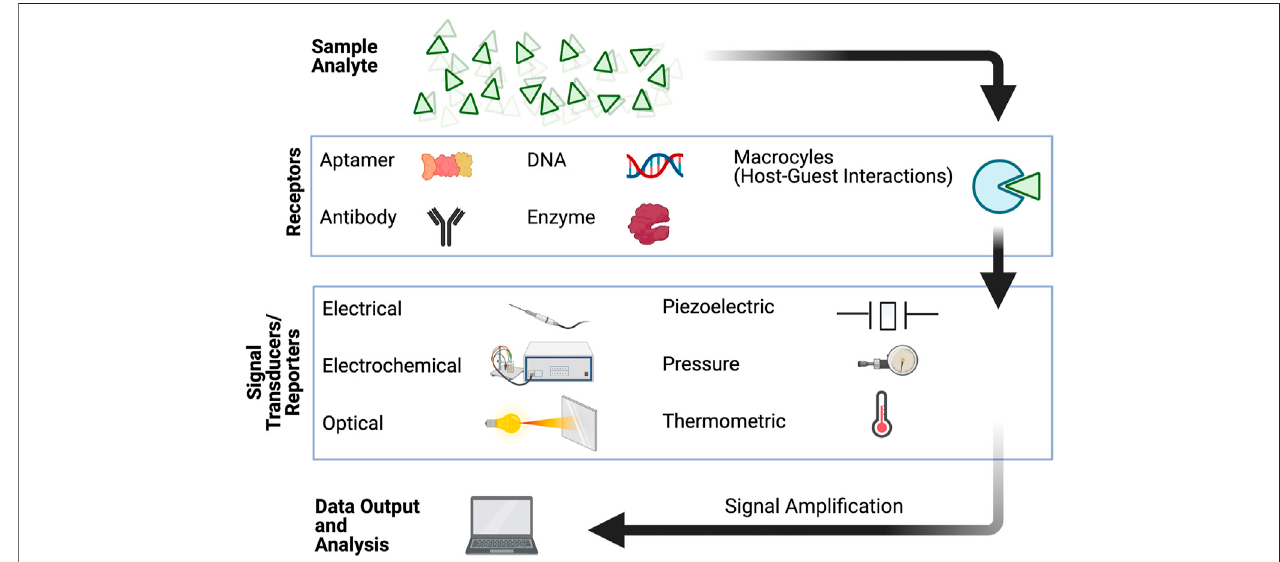
FIGURE 1 | Schematic representation of the components involved in detection and signal transduction for biosensing.